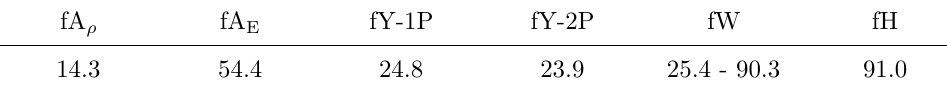
Table 4: Fault-attack success probability in